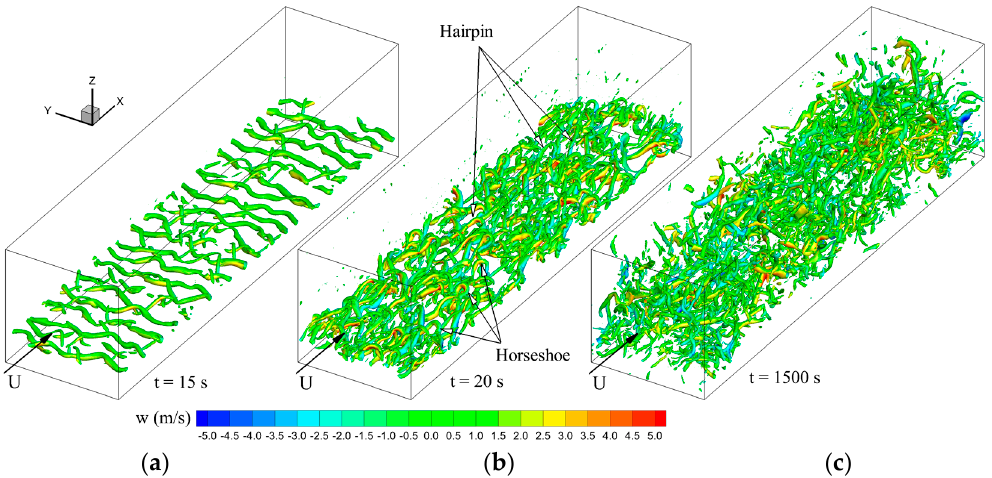
Figure 4. Iso-surface Q = 2 s − 2 of the Q -criterion, colored by the vertical velocity component, obtained in phase 1 for U 10 = 5m/s and LAI = 2. ( a ) t = 15 s, ( b ) t = 20 s, ( c ) t = 1500 s (steady state).